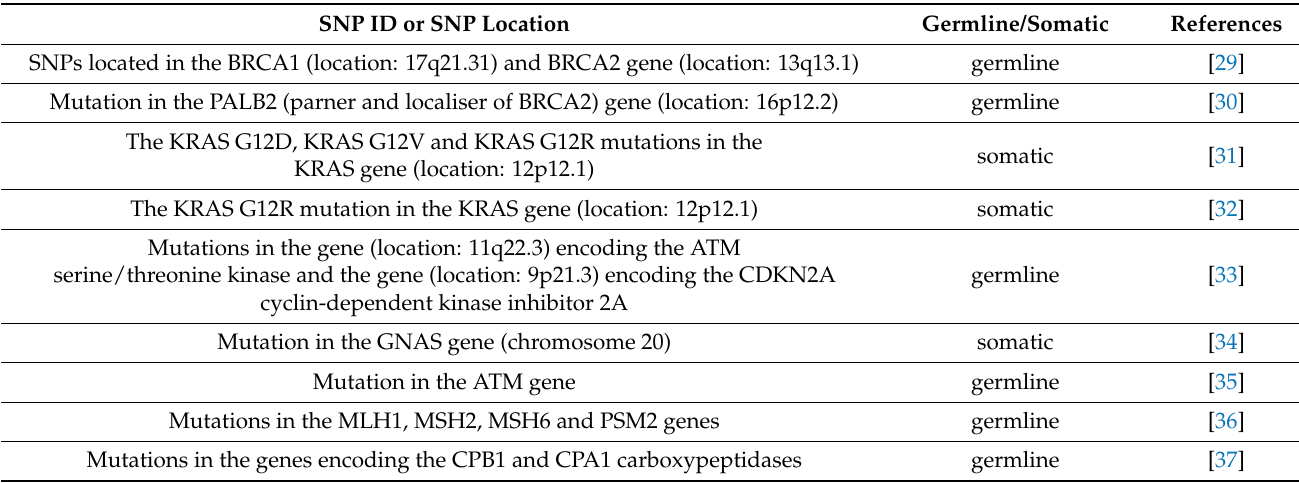
Table 1. Mutations in genes related to pancreatic